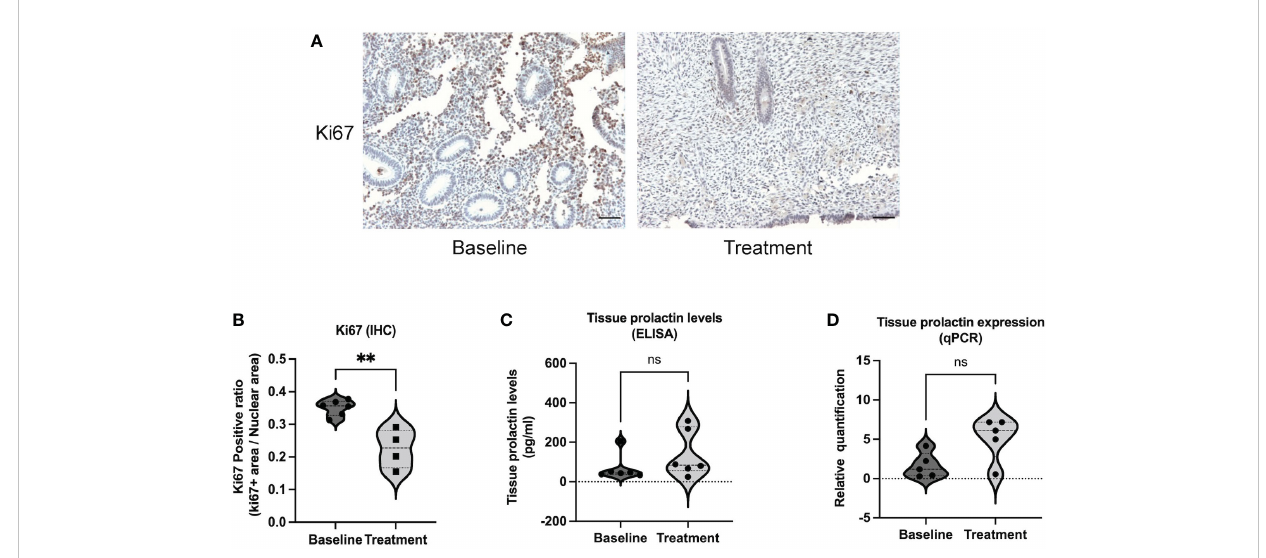
FIGURE 3 Ki67 and prolactin expression in endometrial tissue between baseline and bromocriptine treatment in women with adenomyosis. (A) Representative images of Ki67 immunohistochemistry staining at baseline and after treatment (Magni fi cation of 20×, scale bar:100 m m). (B) The Ki67 positive ratio in endometrial tissue was quanti fi ed by ImageJ. The protein levels of Ki67 decreased signi fi cantly after the treatment of bromocriptine (n=6 for the baseline and n=4 for the treatment). (C) Prolactin concentration in endometrial tissue was evaluated by ELISA (n=6 both for the baseline and treatment). (D) Tissue prolactin mRNA expression levels were determined using real-time PCR (n=5 both for the baseline and treatment). The analysis and plot were generated by GraphPad 9.0. Two-tailed Mann-Whitney U test was performed. ** P < 0.01 indicates a signi fi cant difference. ns indicates no signi fi cant difference.